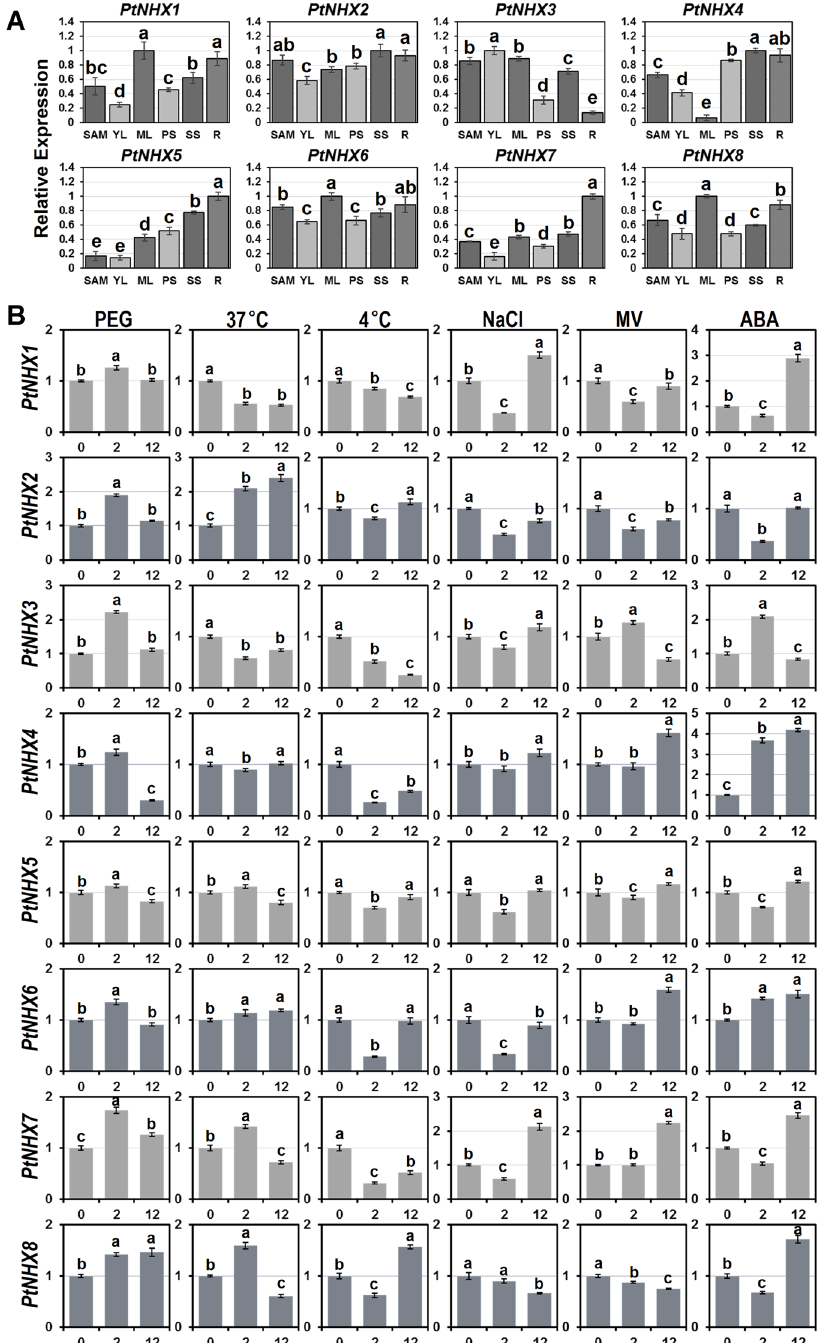
Figure 6. Expression patterns of PtNHX genes in different tissues ( A ) and under various abiotic stresses ( B ) using qRT-PCR. ( A ) The relative mRNA abundance of the PtNHXs were quantified in six tissues (SAM–shoot apical meristems, YL–young leaves, ML–mature leaves, PS–primary stem, SS–secondary stem, R–roots). ( B ) The expression patterns of the PtNHXs at 2 and 12 hours after treated with drought (10% PEG), heat (37 °C), cold (4 °C), salt (150 mM NaCl), oxidative stress (100 μ M MV) or 100 μ M ABA. Bars with the same letters are not significantly ( P <